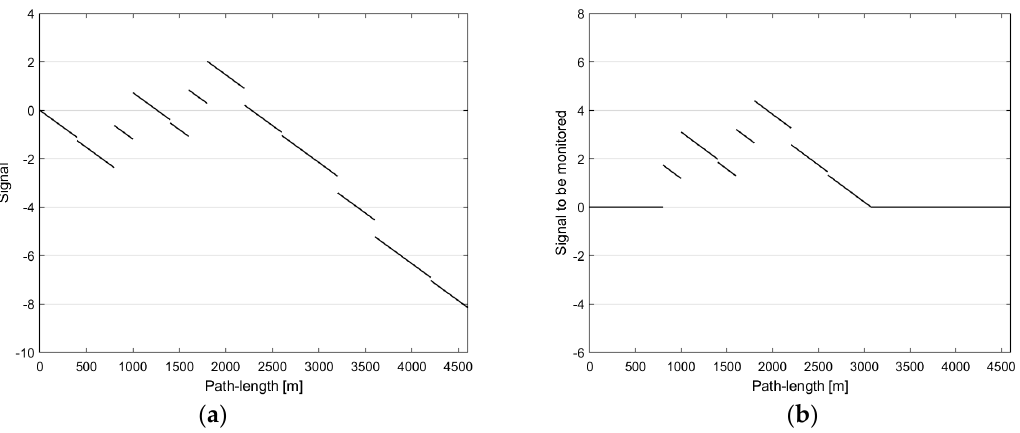
Figure 3. A Res → Dt change detector applied to a Dt → Res transition showing up in the TS sequence given in the top band of Table 2: ( a ) Function g Res → Dt →